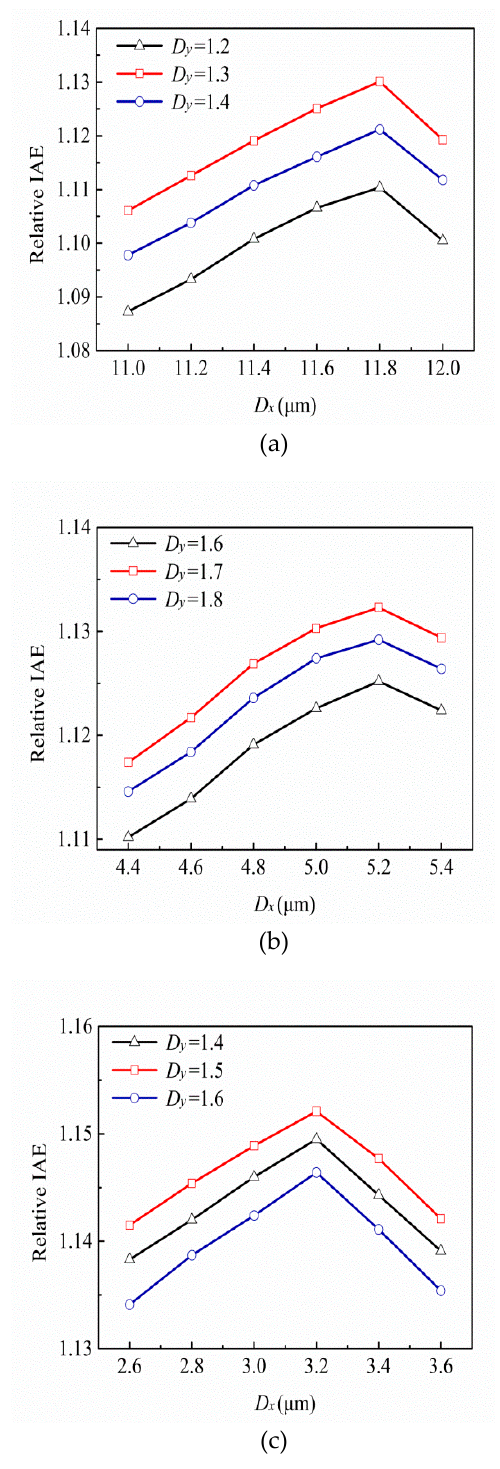
Figure 5. Variances of the relative IAEs with di ff erent W x and W y for the thermopiles with EC-type ESCSs at the target temperature 75 ◦ C, ( a ) one EC, ( b ) two ECs, and ( c ) three ECs. Table 1. Better relative IAEs and geometric parameters for the six ESCSs .